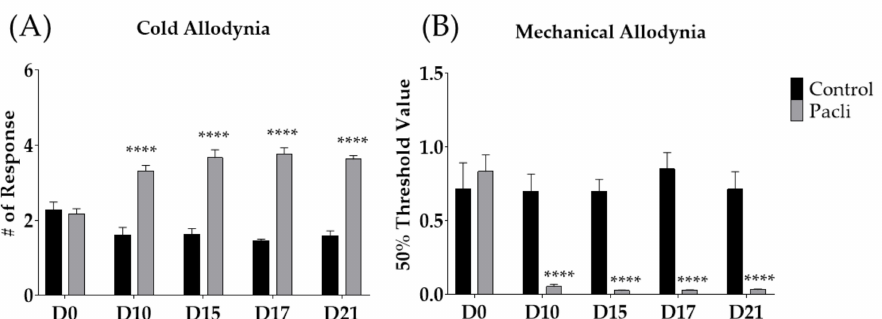
Figure 2. Effect of multiple paclitaxel (Pacli) injections on the response to cold and mechanical stimuli in mice ( A , B ). Paclitaxel was administered intraperitoneally on D0, D2, D4, and D6 (2 mg/kg each). Cold and mechanical allodynia were measured by using acetone-drop and von-Frey-filament tests, respectively. Behavioral tests were conducted before (D0) and 10, 15, 17, and 21 days fol- lowing the initiation of paclitaxel treatment. Control-group mice were injected with a mixture of 50% ethanol and 50% Cremophor EL solution (1:1) as a control of paclitaxel (i.p.). Control: n = 7, Pacli: n = 8. **** p < 0.0001 vs. Control with two-way ANOVA followed by Sidak’s post-test for multiple comparisons.